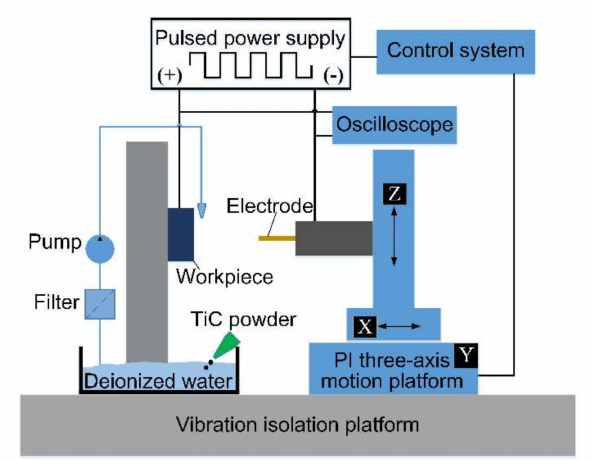
Figure 3. Experimental setup of powder-mixed EDM (PMEDM) .